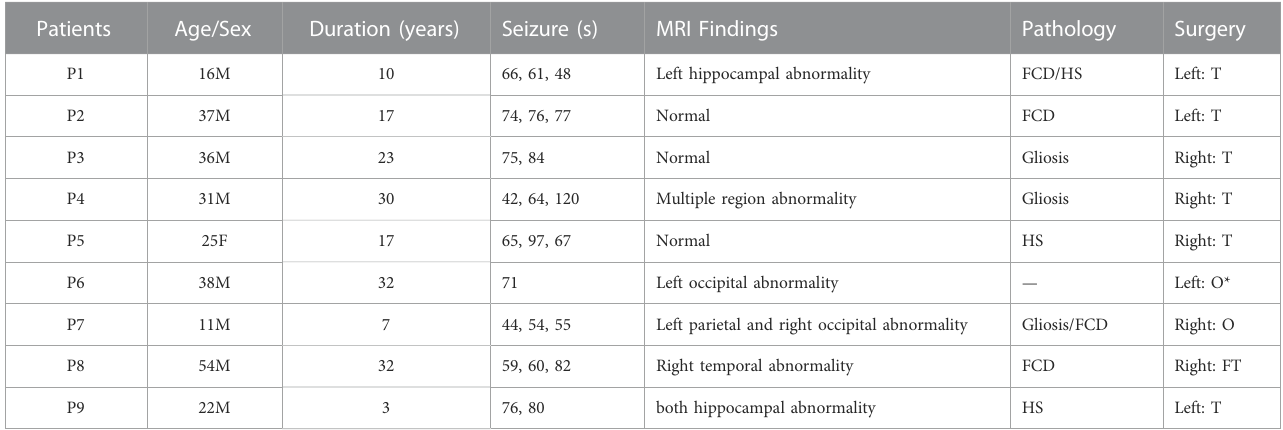
TABLE 1 Clinical information of patients studied in this work.